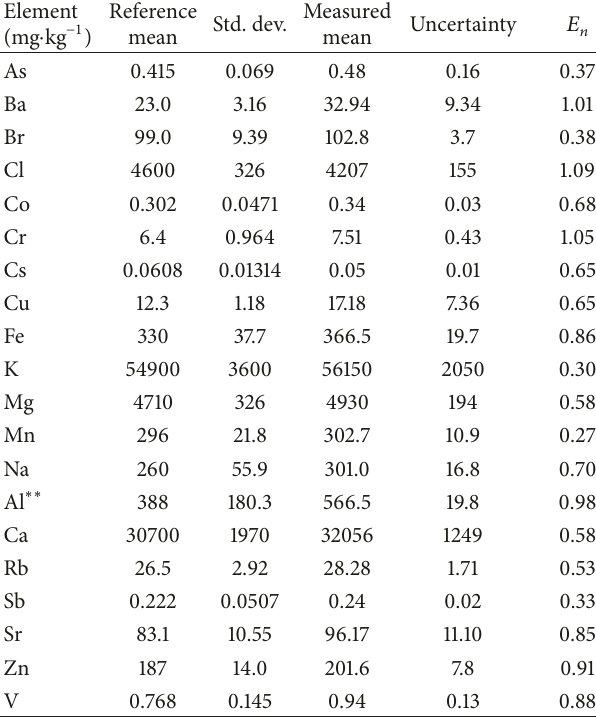
Table 1: IPE sample 205 Tobacco reference material [20] data (con- sensus values) and the NAA 𝐸 𝑛 performance statistics parameter ∗